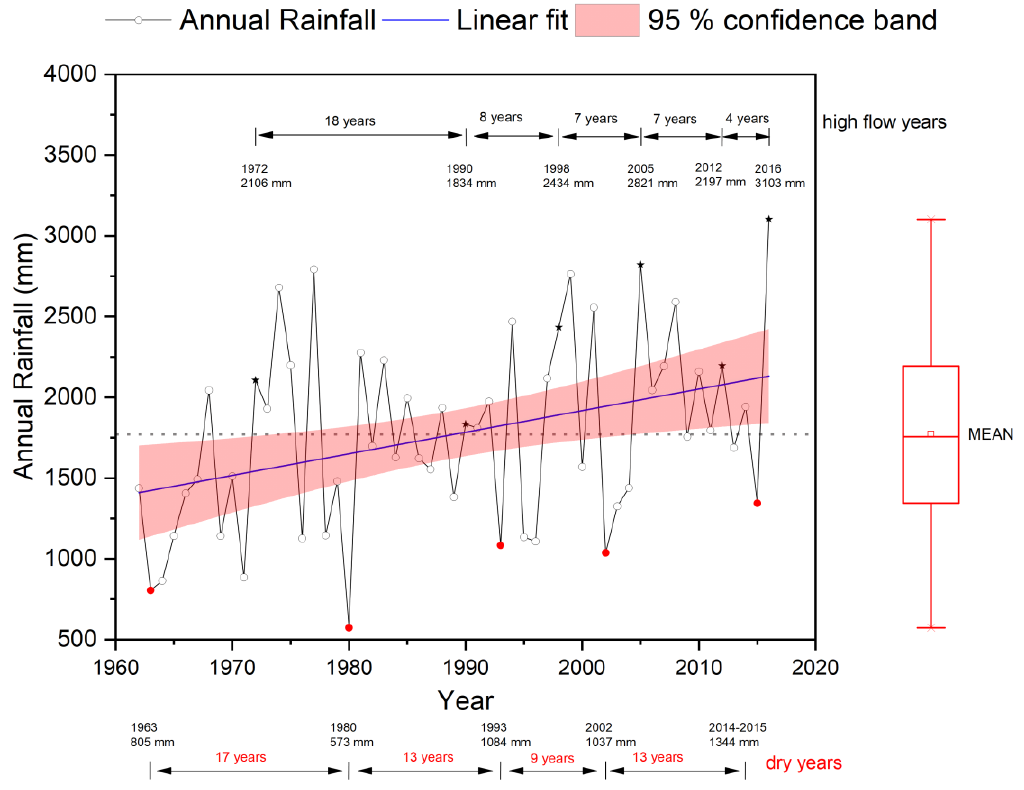
Figure 4. Changes in annual precipitation recorded by the Kaohsiung Weather Station, 1960–2016.